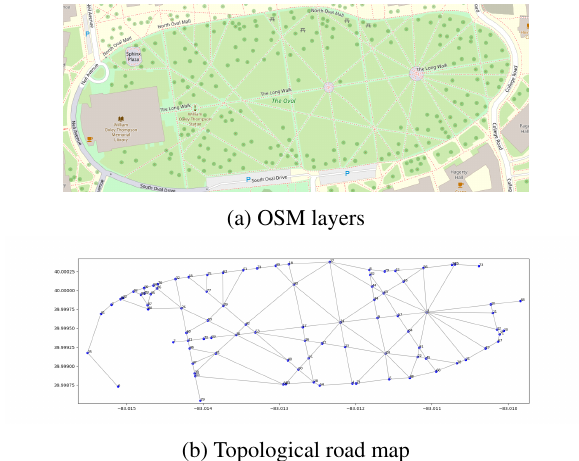
Figure 3. The OSM data and the graph based road representation used in our approach. Each node contains latitude and longitude meta